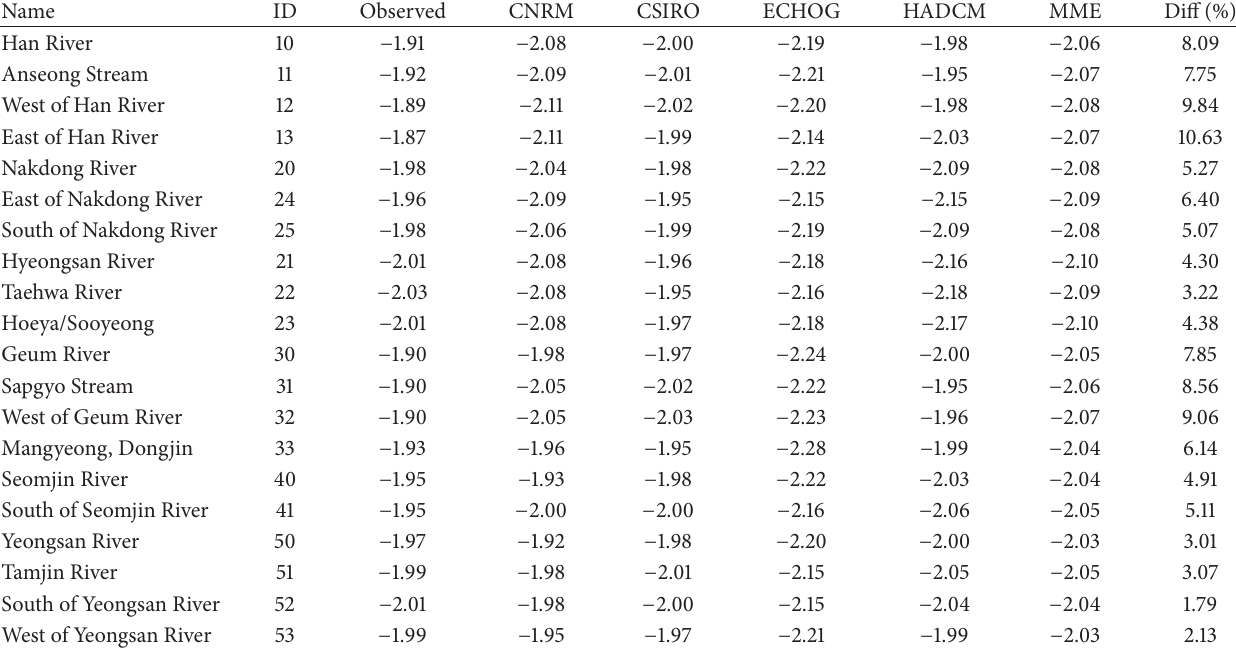
Table 6: Changes in the severity of drought in severe dry stages with three-month SPI less than − 1.5 for past and future climate change projections. Observed severity of drought for the period 1976–2010 and projected change in severity of drought by each GCM and MME average for the period 2011–2099 for the climate change scenario. Difference is a percentage change in severity of drought between past and future periods, and positive value indicates increasing trend and vice versa. Note that the SPI series is calculated from a downscaled